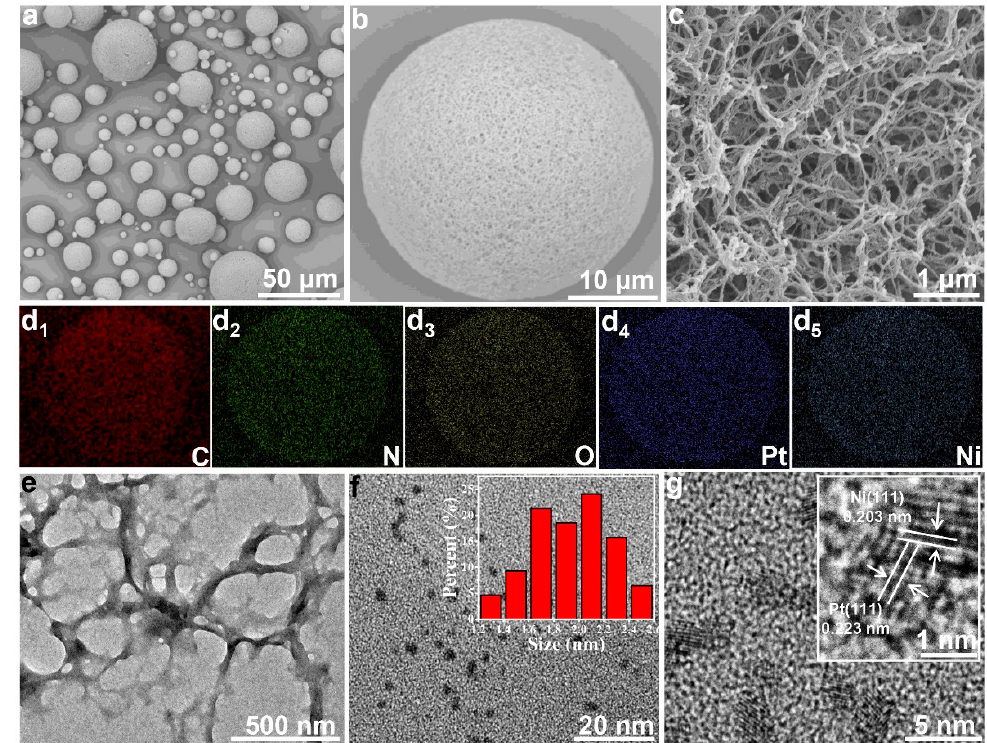
Figure 3. SEM images of the chitin microspheres ( a – c ). EDX mapping of the Pt–Ni/Chitin ( d 1 − d 5 ). TEM images of the Pt–Ni/Chitin ( e – g ), inset ( f ) with the particle size distribution, inset ( g ) with the HR-TEM image of a single Pt–Ni particle.